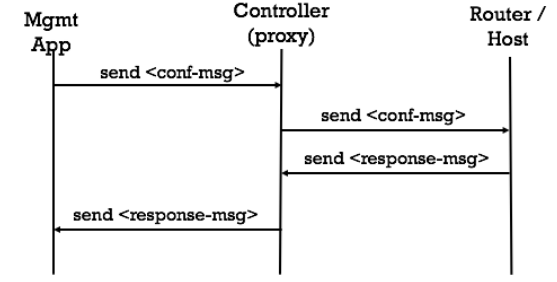
Figure 4. Illustration of SDN Proxy Protocol Table 1. SDN Discovery Protocol